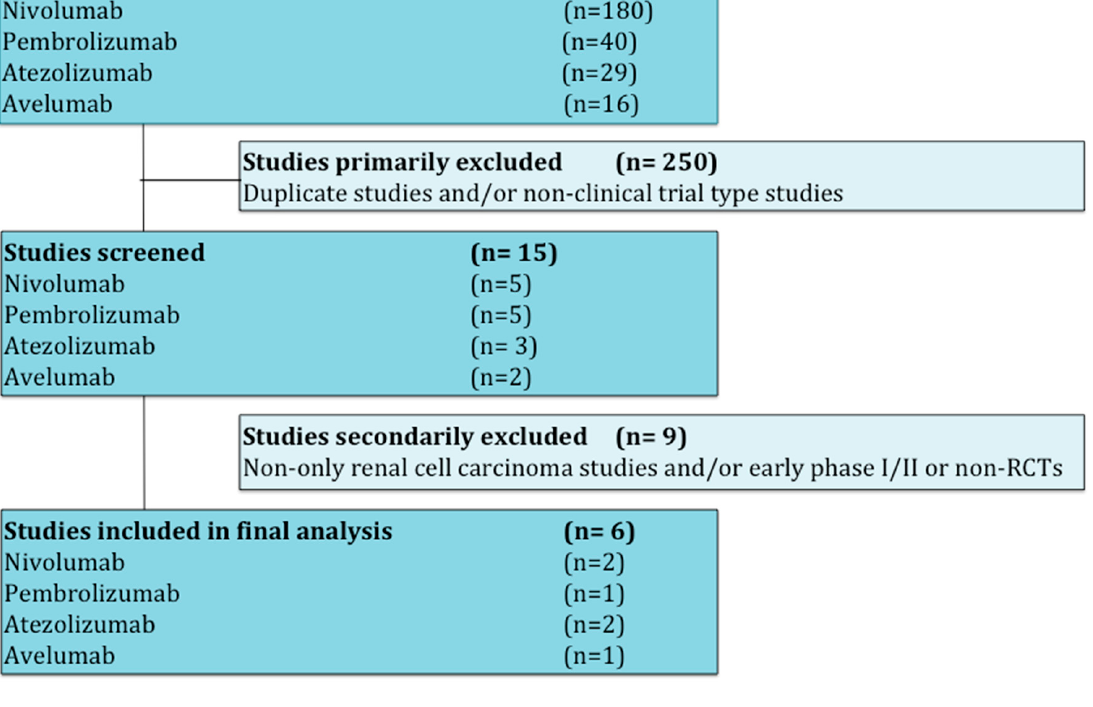
Figure 1. Flow diagram for identification and selection of studies.